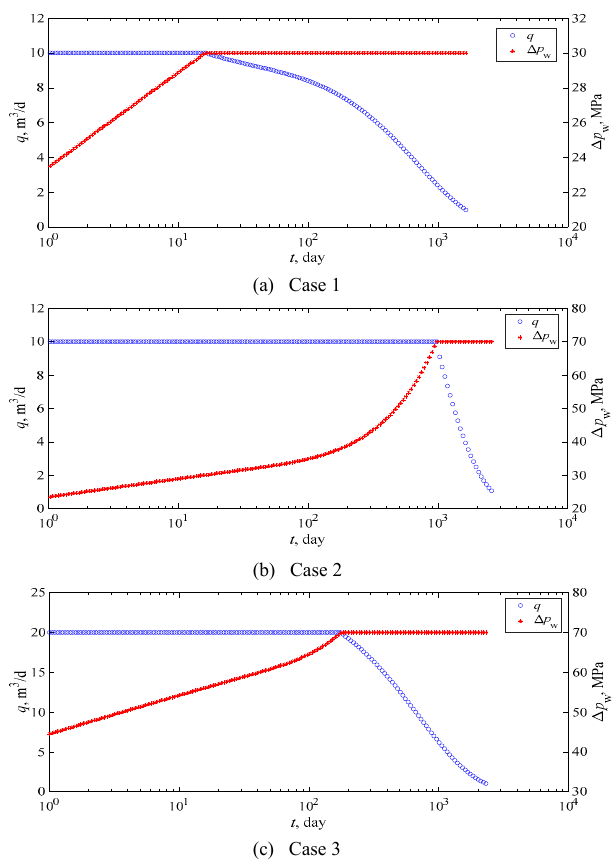
Figure 18. Production data for Cases 1–3 with variable rate and pressure.